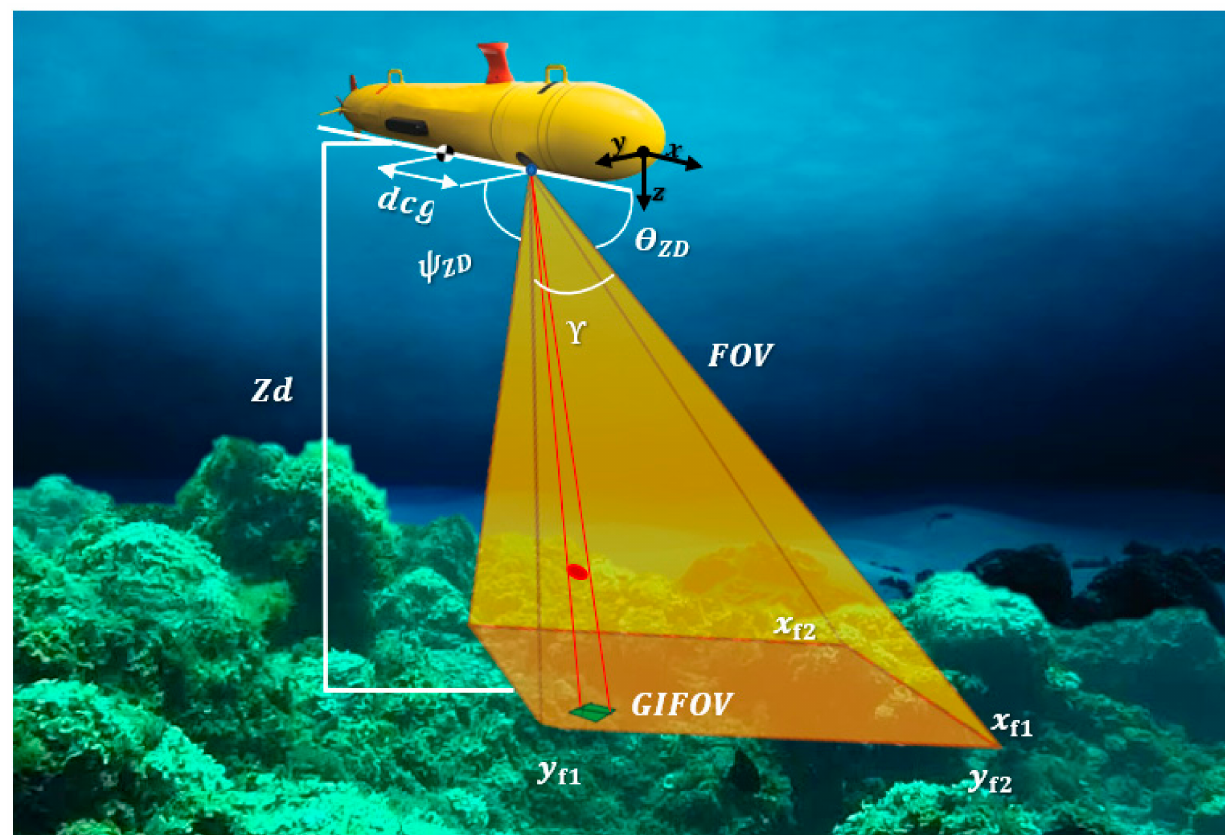
Figure 5. AUV measurement conditions with FOV